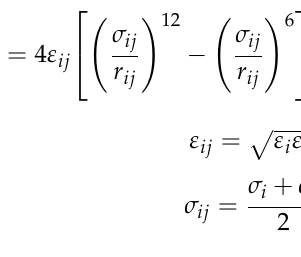
Table 1. 12-6 Lennard-Jones potential